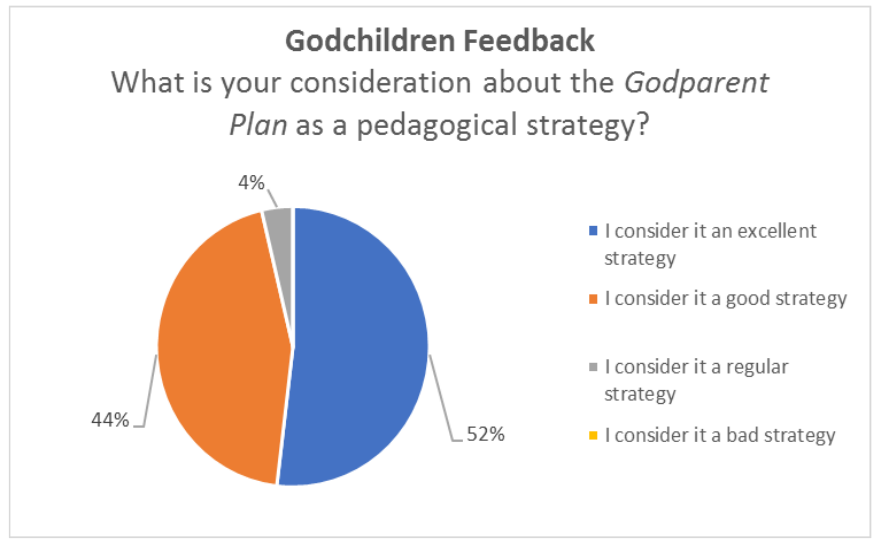
Fig. 2. Godchildren’ consideration about the Godparent Plan as a pedagogical strategy